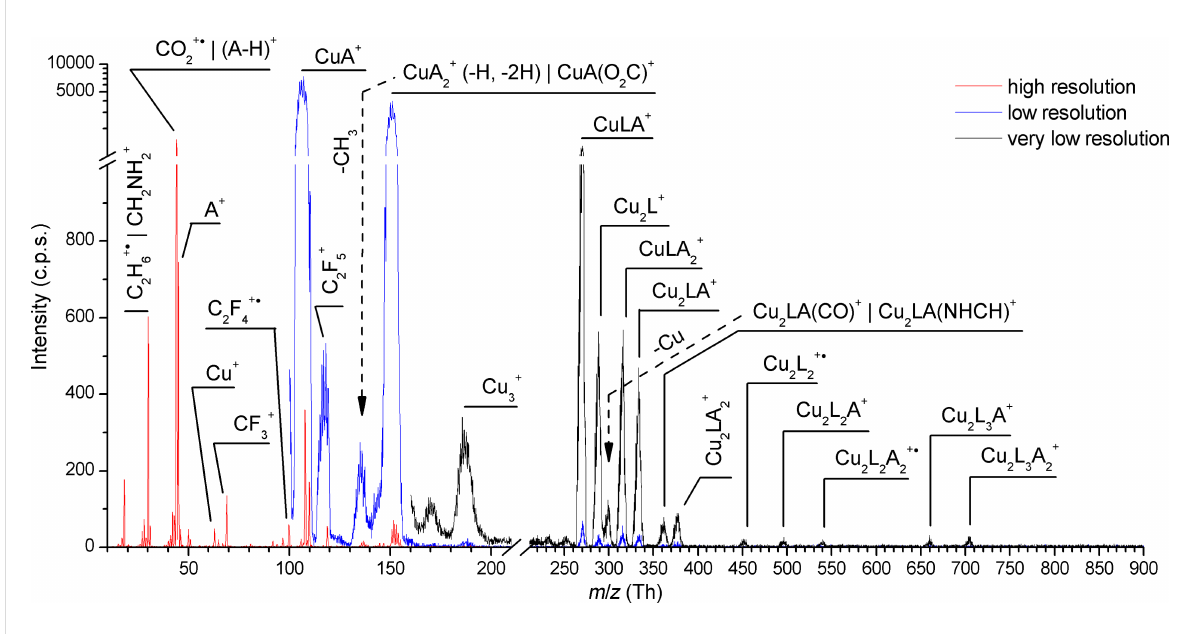
Figure 4: Mass spectrum of [Cu 2 (EtNH 2 ) 2 (µ-O 2 CC 2 F 5 ) 4 ] molecule over the range m / z 10–900 obtained at electron energy 70 eV and temperature of the beam source of ≈ 80 °C. The spectral range below m / z 200 was measured with higher mass resolution (red line), while that range above m / z 100 (blue line) and above m / z 160 (black line) was measured with lower mass resolutions to increase the signal.